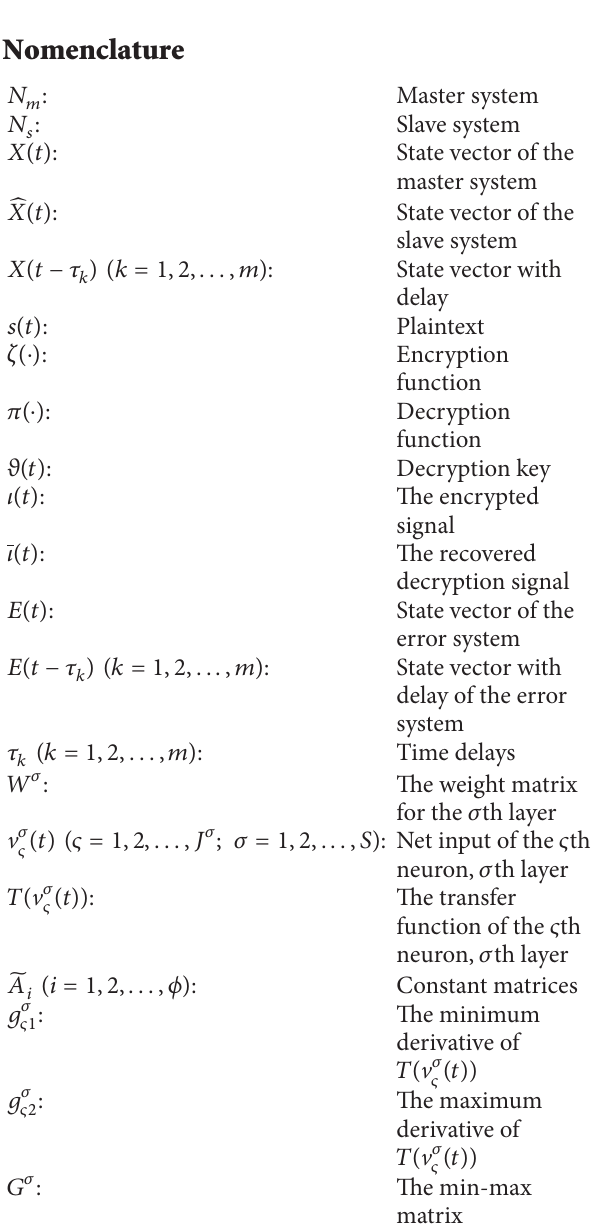
synchronization of two different MTDC systems can be achieved by the designed fuzzy